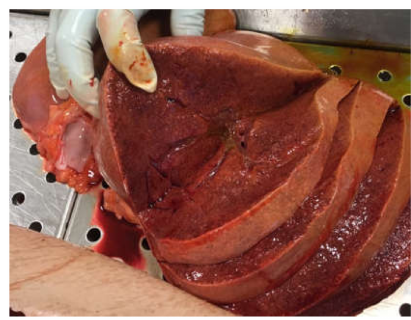
Figure 3. Cirrhotic degeneration of the